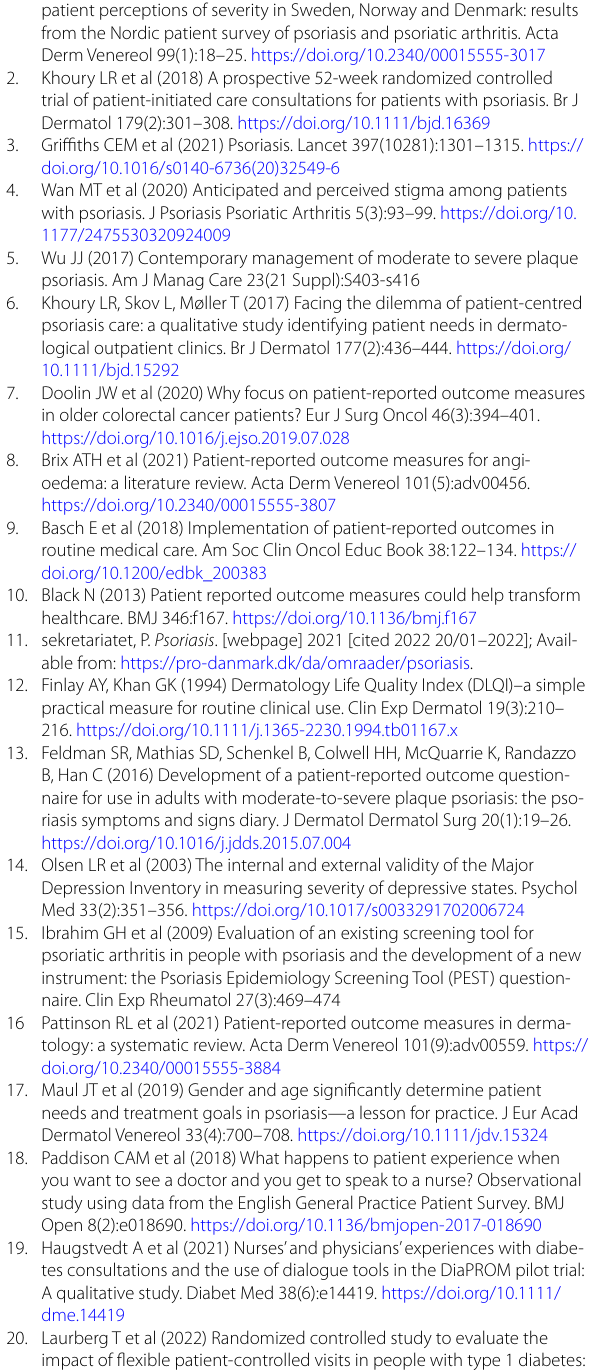
respondents. Table 3 . The 120 comments from patients, doctors, and nurses sorted across nine themes. Table 4 . The subgroup analyses of patients with a PROM coded as red or